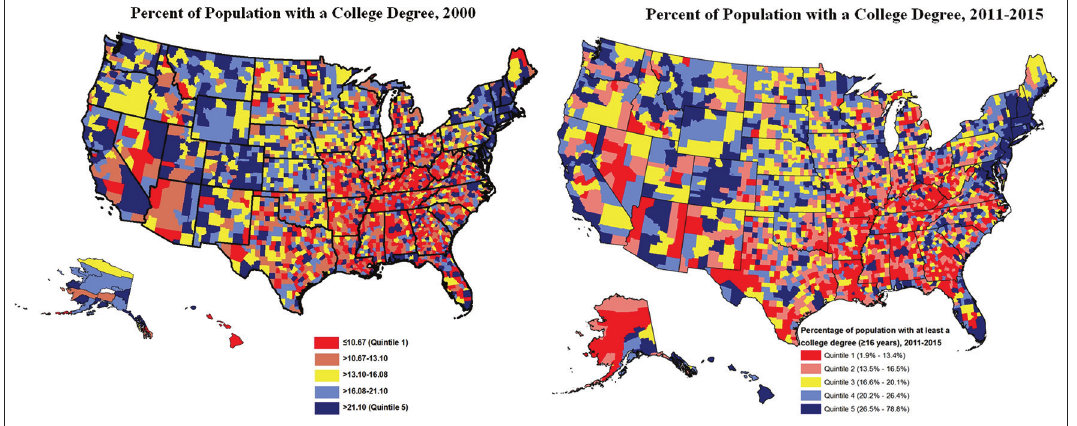
Figure 2 . Percentage of Population aged ≥25 Years with a College Degree, United States, 2000 and 2011-2015 (3,143 Counties) Source: Data derived from the 2000 Census and 2011-2015 American Community